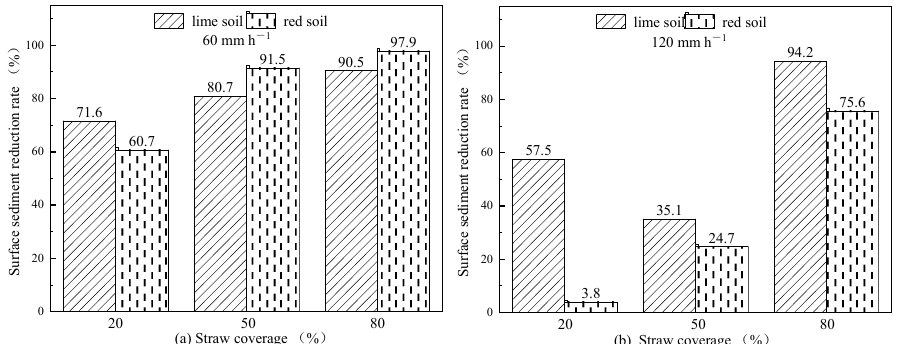
Figure 4. The Sediment reduction rate of red soil and lime soil at 60 mm/h ( a ) and 120 mm/h ( b ) rainfall intensities with different straw coverage. (The sediment reduction rate refers to the ratio of the difference between the total surface sediment production without straw mulch, minus the total surface sediment production with straw mulch, to the total surface sediment production without straw mulch).